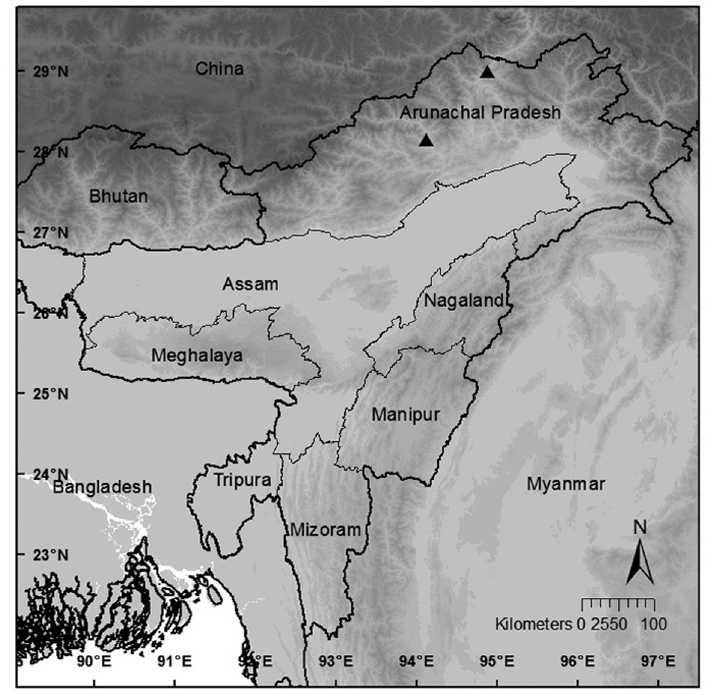
Fig. 59. Map showing the location of B. tessaricarpa C.B.Clarke